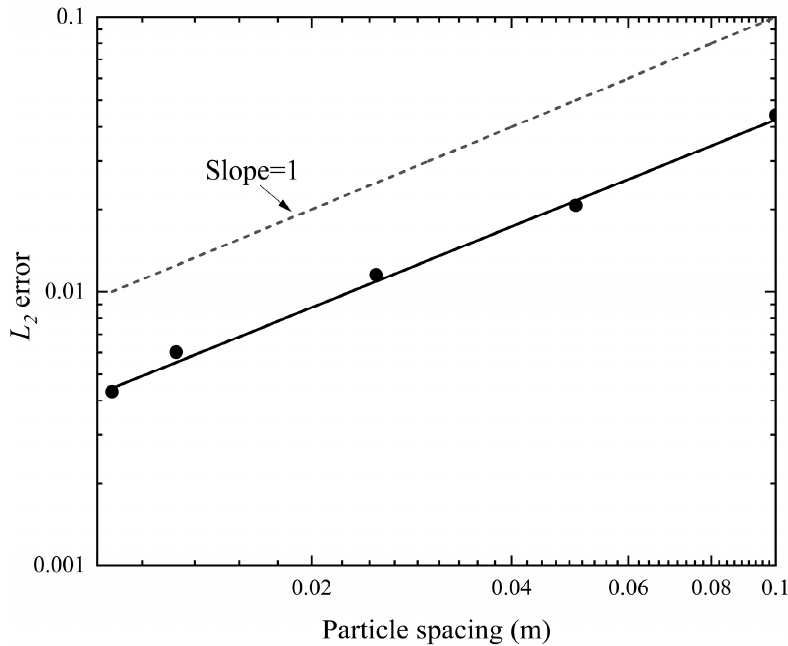
Figure 12. Numerical solution convergence result for the multiphase δ -plus-SPH